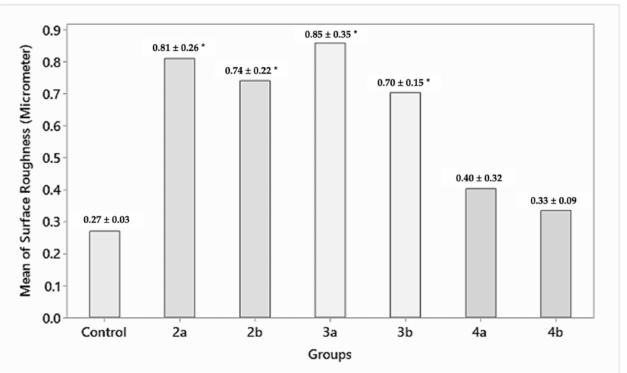
Figure 4. Surface roughness (Ra) in µ m of the abraded zirconia samples (microns). * Statistically significant difference between the groups.